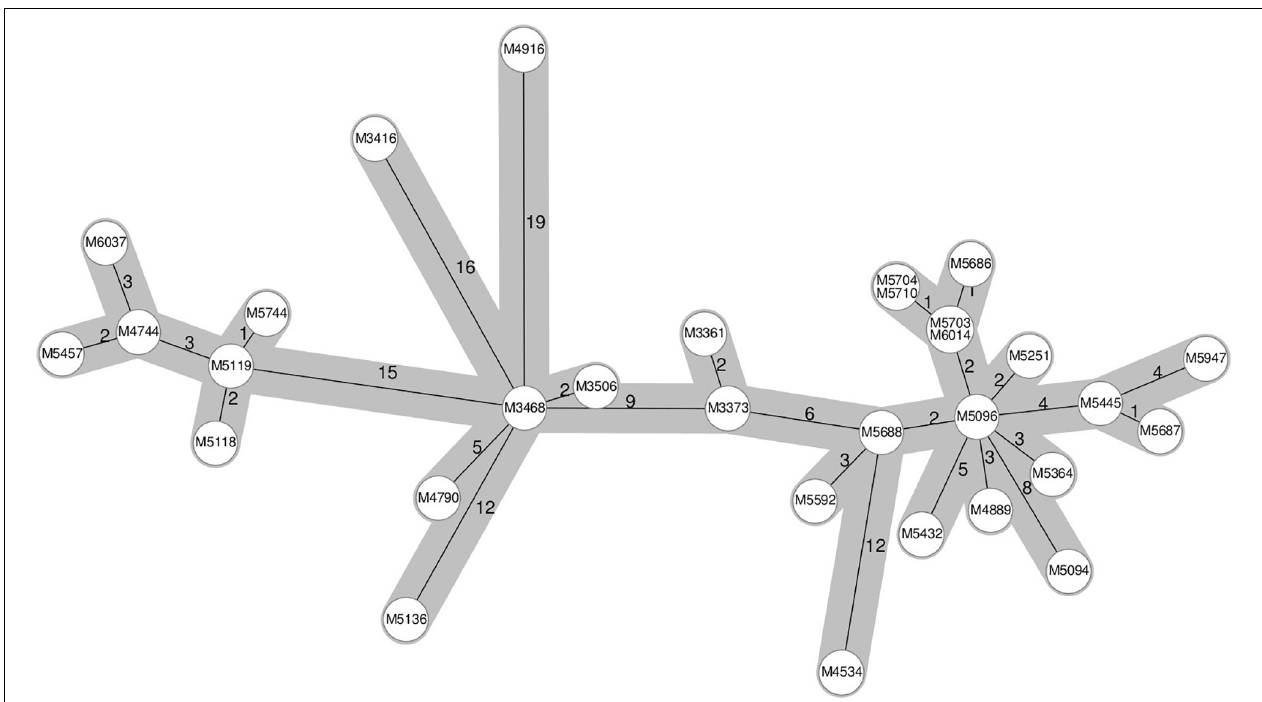
FIGURE 2 | Ridom SeqSphere+ cgMLST minimum spanning tree of a 5-year-long hospital-related outbreak. The numbers on the edges between the nodes denote the allelic distances between samples.